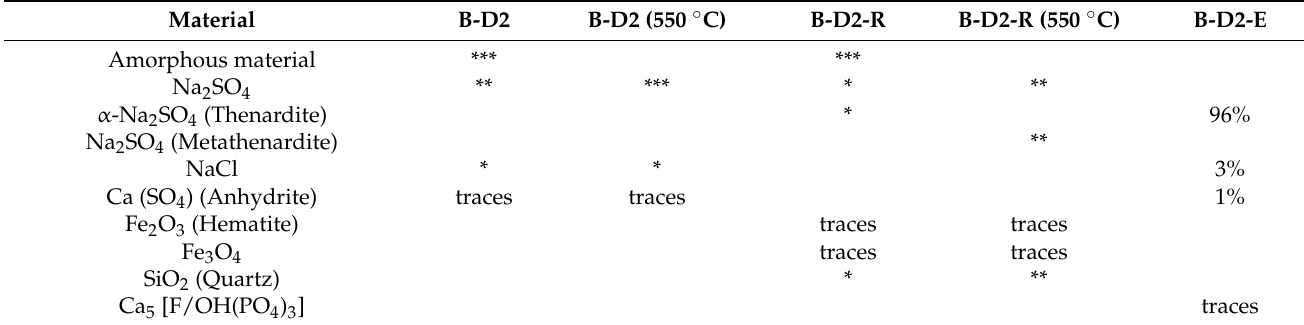
Table 5. Results of the XRD investigation and semiquantitative assessment (continued).